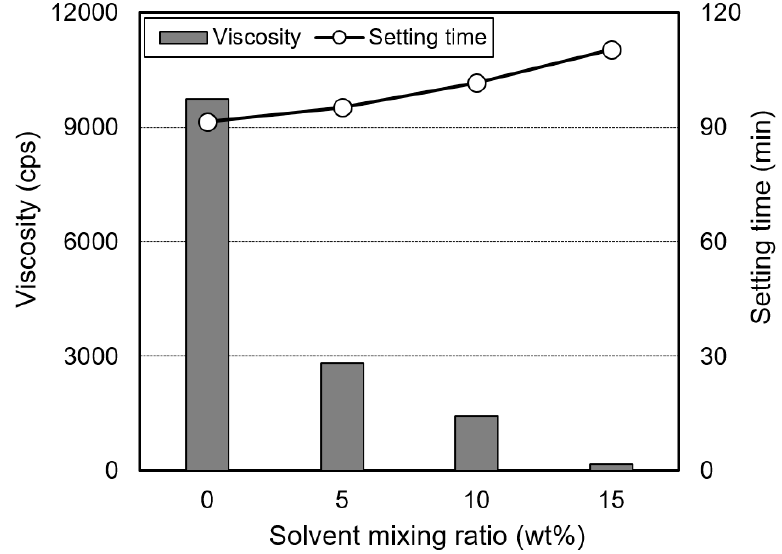
Figure 6. Viscosity and setting time of epoxy resin based on the solvent mixing ratio.